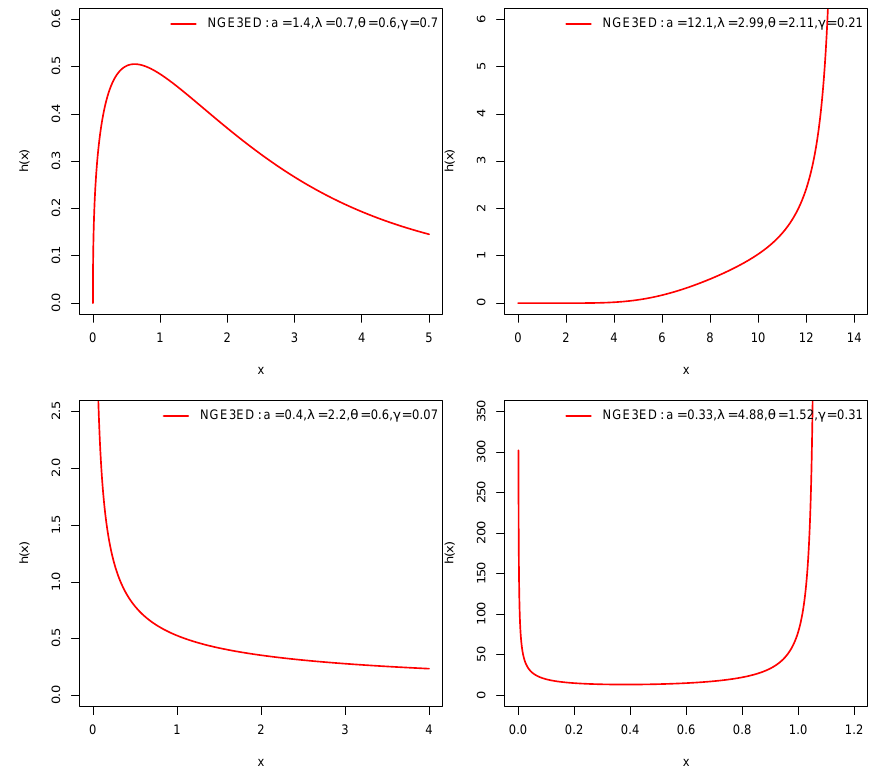
Figure 3. FRF plots of